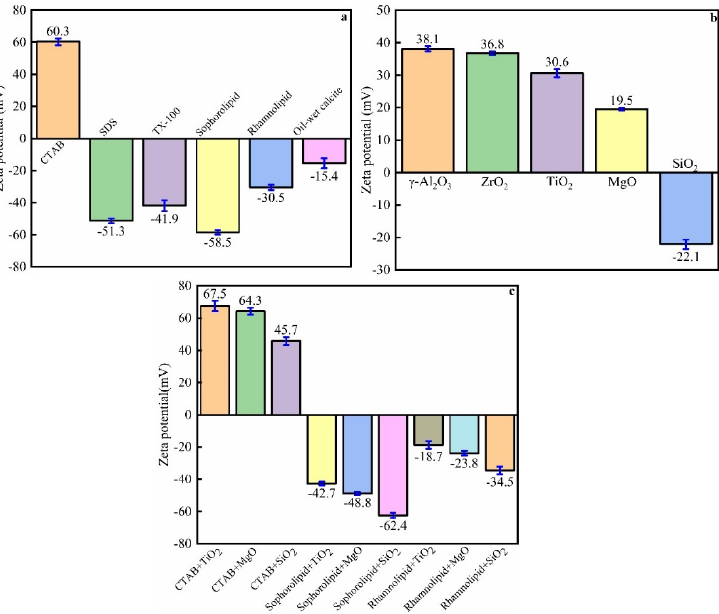
Figure 19. Zeta potential of ( a ) 500 ppm surfactants; ( b ) 0.1 wt% nanofluids; ( c ) 500 ppm surfactant and 0.1 wt% nanofluid hybrid solutions.